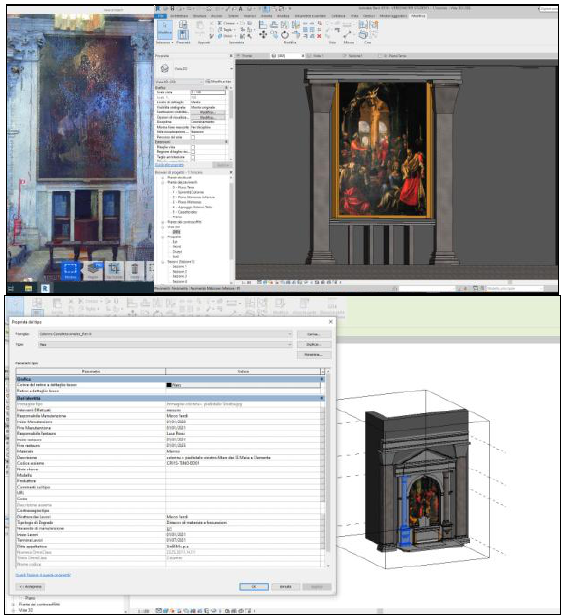
Figure 7. The modeling according the maintenance